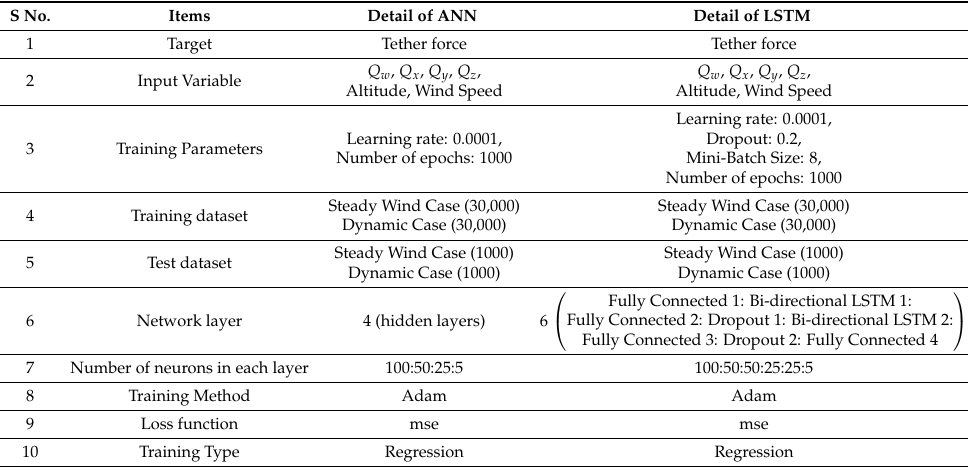
Figure 13. The flow of the estimation of the tether force using the DNN methods: The field test data were imported to the models and then normalised so that they could be used in the ANN and LSTM models; the predicted data in the normalised form were then inverted to the actual values; the performance was evaluated using the RMSE, MAE, and R 2 methods. Table 4. Details of the parameters used in the Deep Learning Models—ANN and LSTM: S